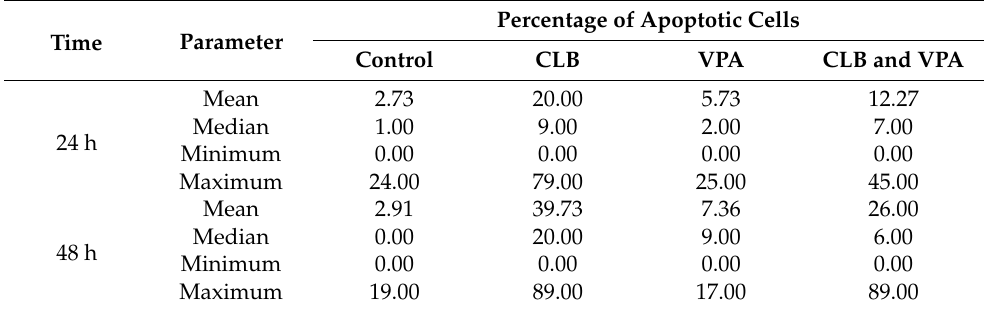
Table 1. Percentage of apoptosis in the cultures of chronic lymphocytic leukemia (CLL) cells treated with chlorambucil (CLB), valproic acid (VPA) and combination of CLB and VPA ( n = 17).